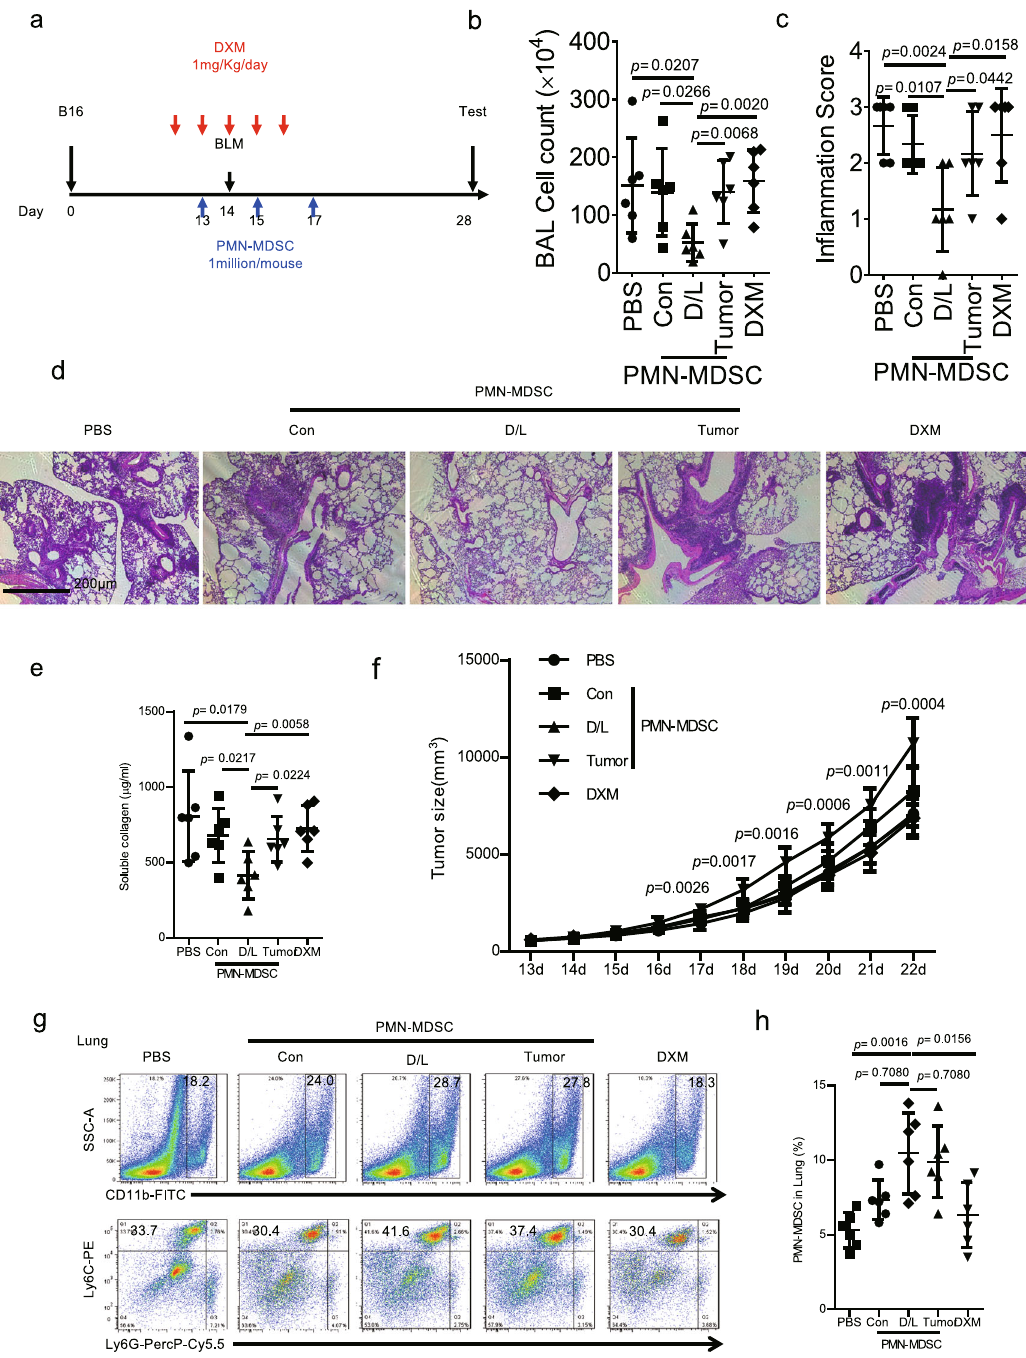
Fig. 6 Transfer of DXM/lactoferrin PMN-MDSC relieved bleomycin-induced interstitial pneumonia without promoting tumor development. a Diagram of the experimental design. BLM sulfate (2 U/kg) was administered intratracheally to wild type (WT) mice through tracheotomy under iso fl urane anesthesia 14 d after tumor implantation, and tested on day 28. For PMN-MDSC transfer experiments, 1 × 10 6 cells of Con PMN-MDSC, DXM/lactoferrin (D/L) PMN-MDSC, tumor PMN-MDSC, or vehicle control (PBS) was administered i.v. before BLM challenge on day 13 every other day three times. DXM was administered at 1 mg/kg/day from day 12 through day 16 in the indicated group. b Total cell counts in the bronchoalveolar lavage fl uid (BALF). c Histopathological scores. d Representative images of hematoxylin and eosin-stained sections of the lungs. e Collagen content in the lungs. f Tumor growth. g Typical example of fl ow cytometric analysis and h statistical analysis of PMN-MDSCs in the lungs ( n = 6 biologically independent animals). Error bars displayed the mean and standard